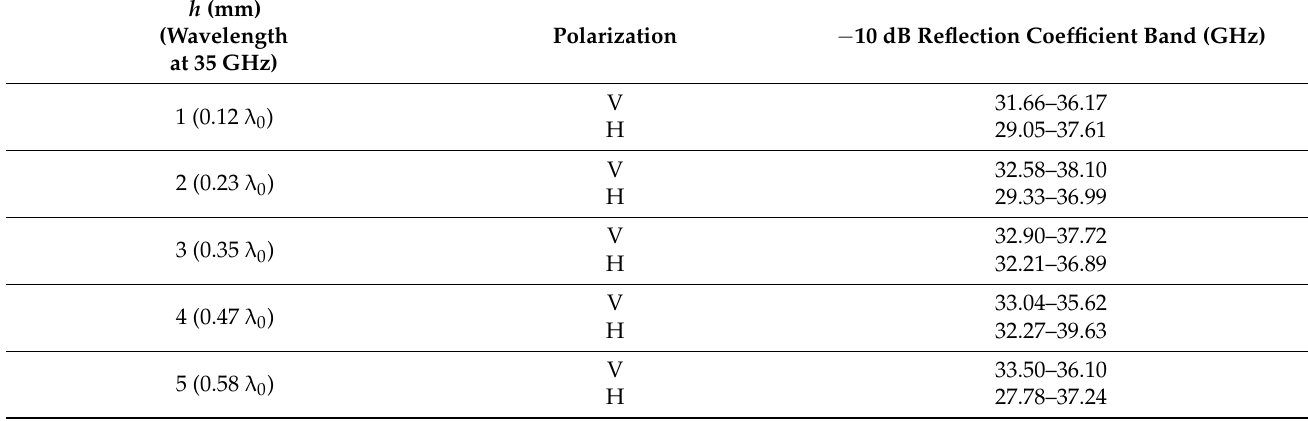
Table 3. Simulated − 10 dB reflection coefficient performances for various h